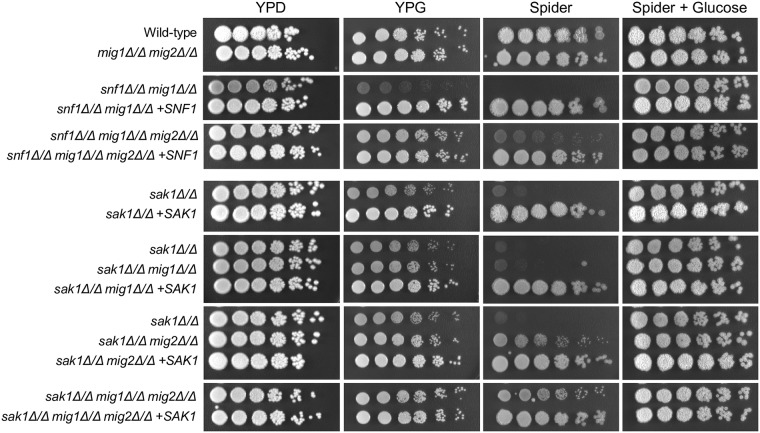
Impact of MIG1/2 mutations on growth of sak1 or snf1 mutant and validated strains.Tenfold serial dilutions of strains KL988(sak1Δ/Δ), KL951(sak1Δ/Δ mig1Δ/Δ), KL960(sak1Δ/Δ mig2Δ/Δ), KL955(sak1Δ/Δ mig1Δ/Δ mig2Δ/Δ), KL992(sak1Δ/Δ +SAK1), KL972(sak1Δ/Δ mig1Δ/Δ +SAK1), KL990(sak1Δ/Δ mig2Δ/Δ +SAK1), KL974(sak1Δ/Δ mig1Δ/Δ mig2Δ/Δ +SAK1), and KL953 (snf1Δ/Δ mig1Δ/Δ), KL957(snf1Δ/Δ mig1Δ/Δ mig2Δ/Δ), KL970 (snf1Δ/Δ mig1Δ/Δ +SNF1), and KL976(snf1Δ/Δ mig1Δ/Δ mig2Δ/Δ +SNF1) were spotted on YPD (glucose), YPG (glycerol), Spider media (mannitol) and Spider media with 2% glucose replacing mannitol. Growth was visualized after 48 h of incubation at 37°C.